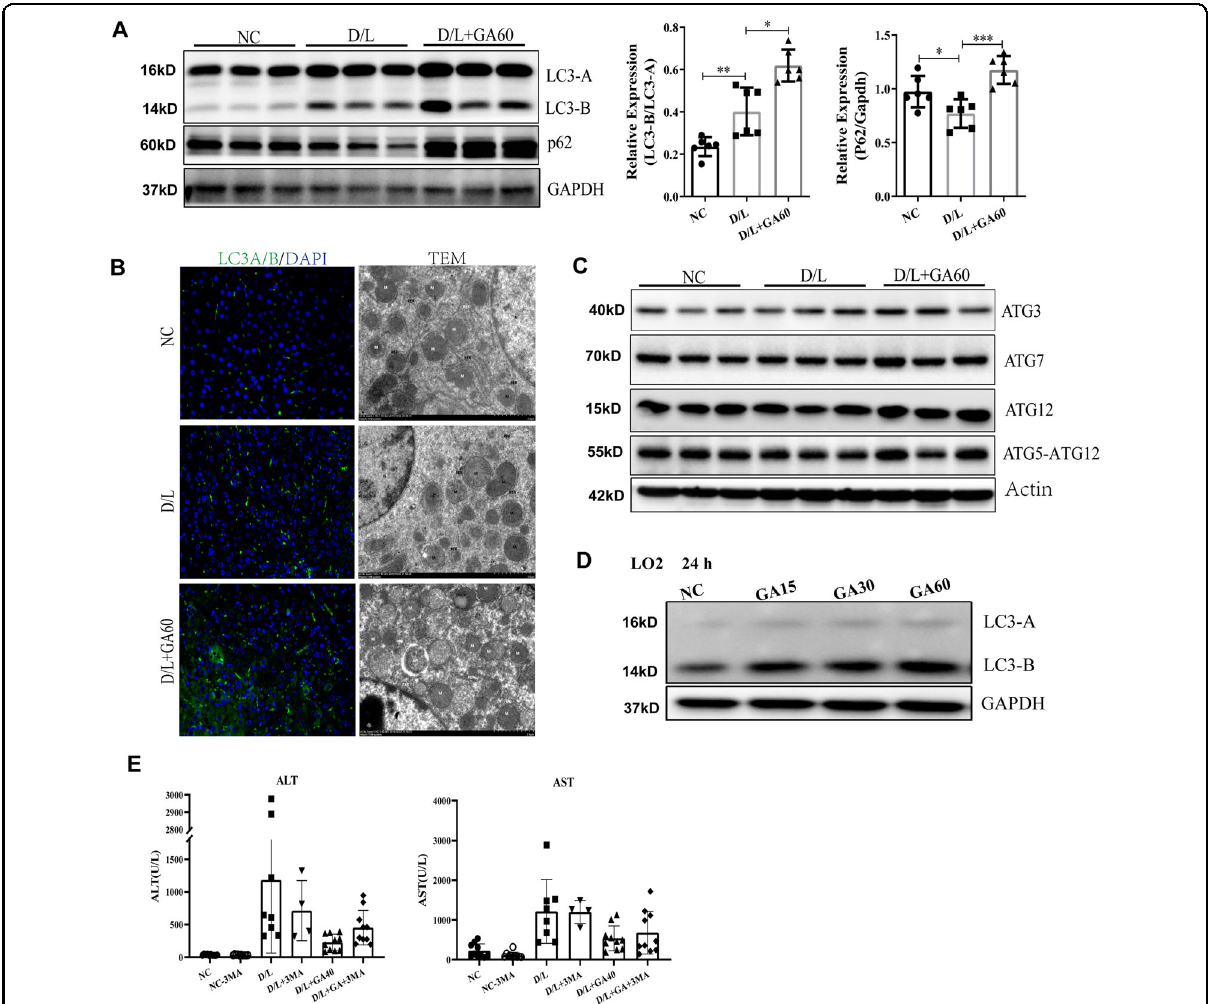
Fig. 2 GA treatment causes the accumulation of LC3-B and P62. In rat liver tissue ( n = 6), the levels of LC3-B and P62 ( A ) and autophagosome formation-related proteins ( C ) were detected by western blot, autophagosomes were detected by immuno fl uorescence staining and transmission electron microscopy (TEM) images ( B ). LO2 cells were treated with different concentrations of GA for 24 h and the level of LC3-B was examined by western blot ( D ). ALT and AST of C57 mice cotreated with D/L and with or without GA (40 mg/kg) or 3-MA (the autophage inhibitor, 30 mg/kg) were measured ( n = 10) ( E